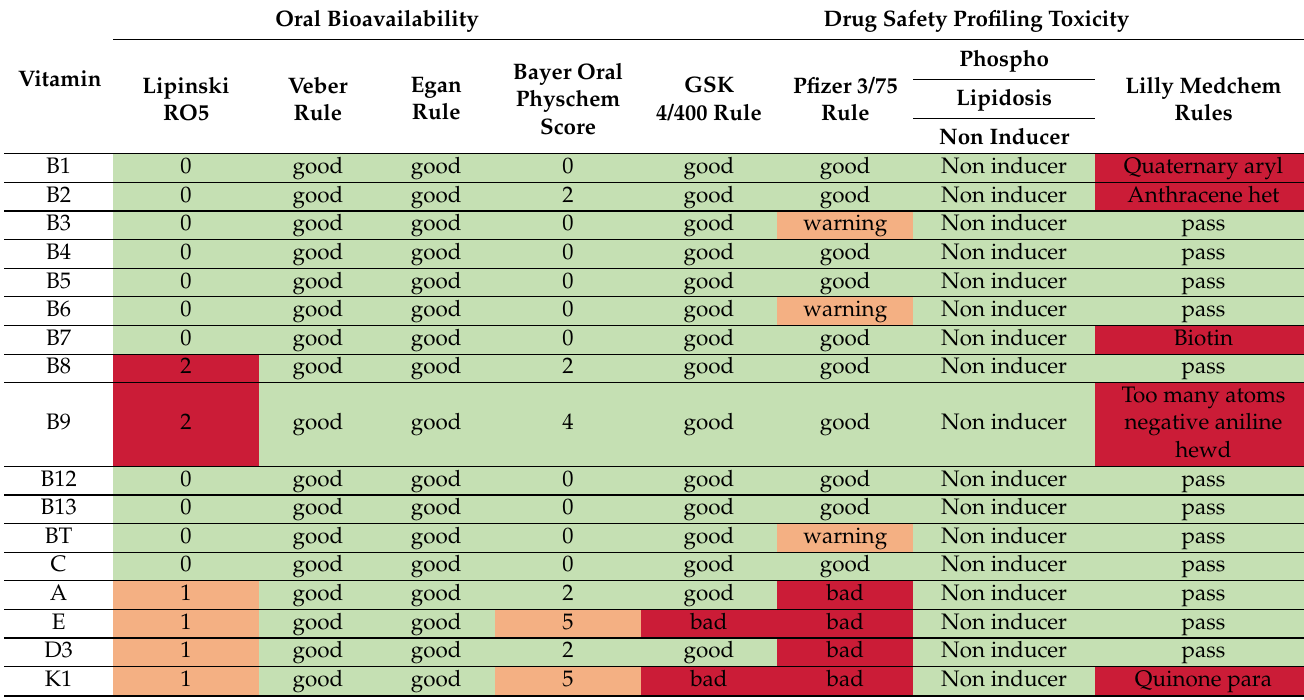
Table 2. ADMET profiles for hydro- and liposoluble